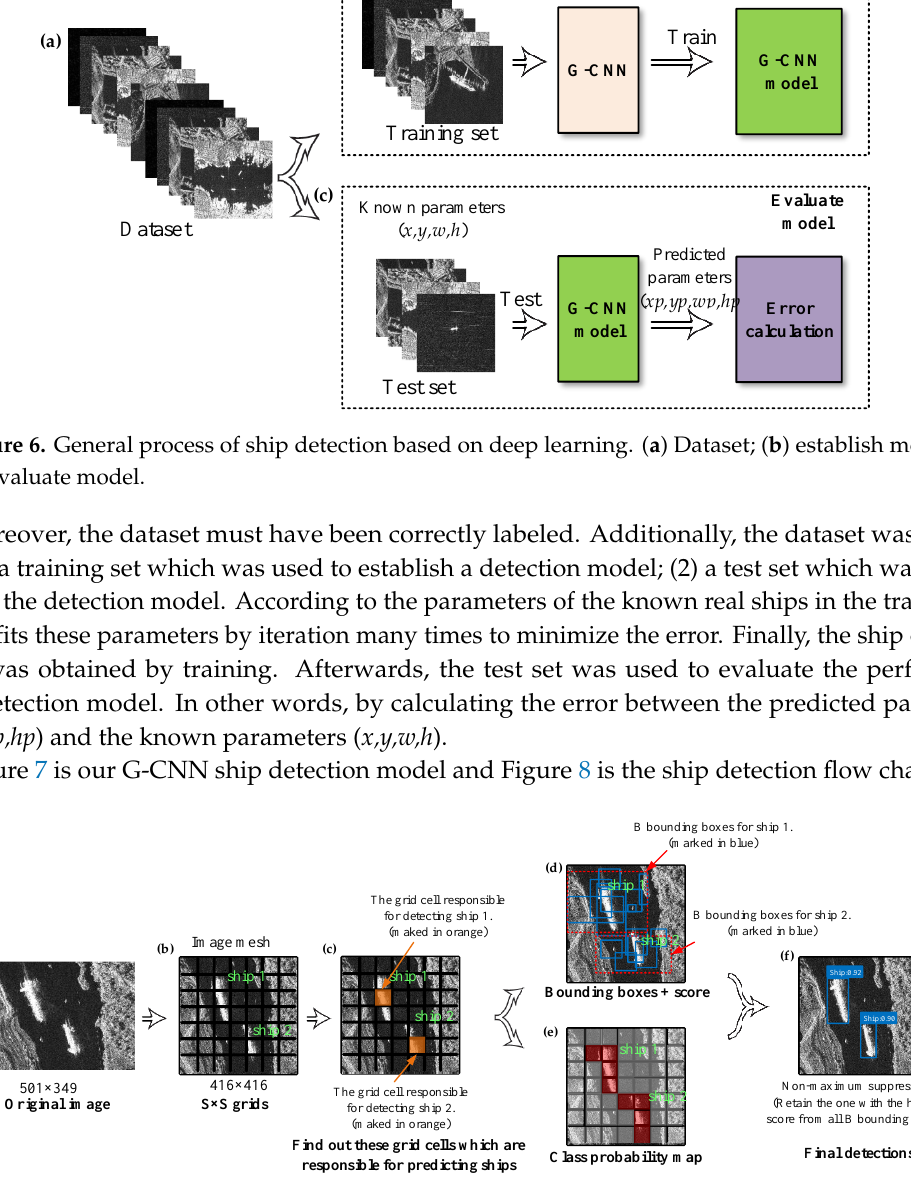
Figure 7. G-CNN ship detection model. ( a ) Original image; ( b ) S × S grids; ( c ) find out these grid cells which are responsible for predicting ships; ( d ) bounding boxes + score; ( e ) class probability map; ( f ) final detections.